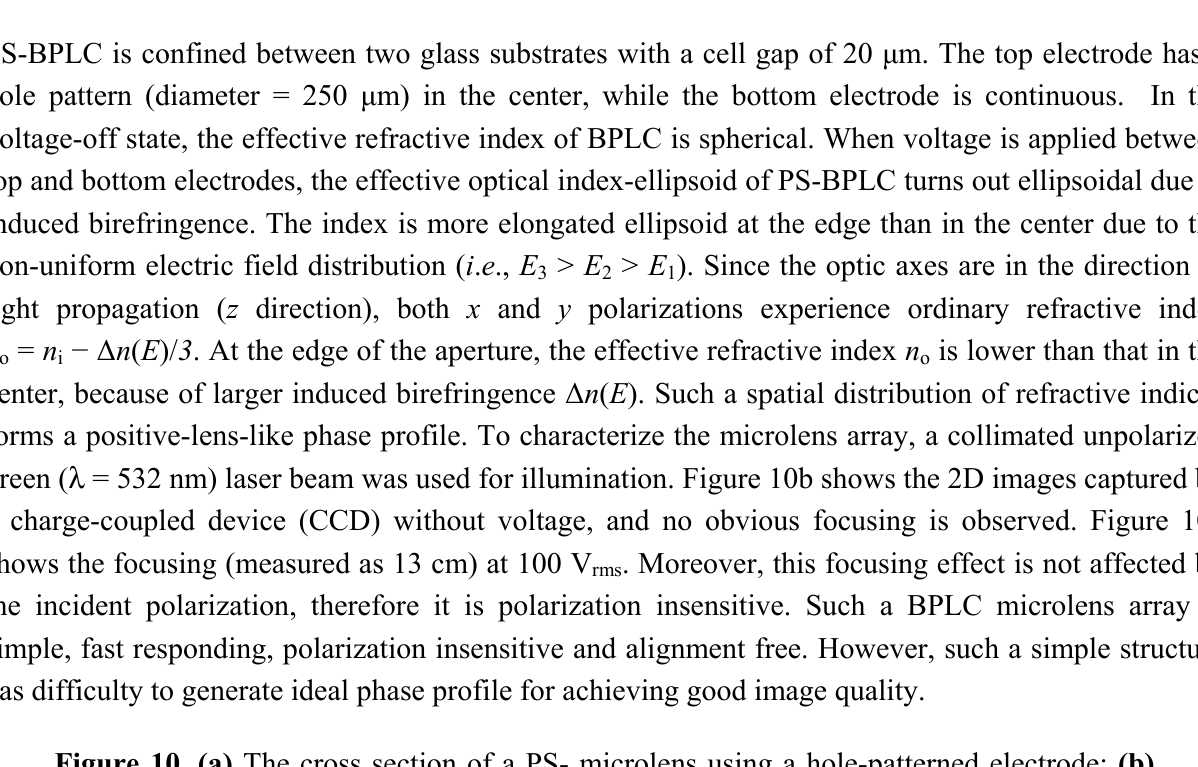
Figure 10. (a) The cross section of a PS- microlens using a hole-patterned electrode; (b) measured CCD images of the 2D microlens array at 0 V